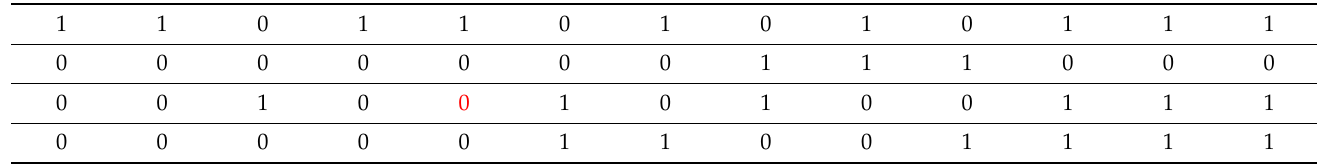
Table 10. New chromosome derived from the array mutation operator.